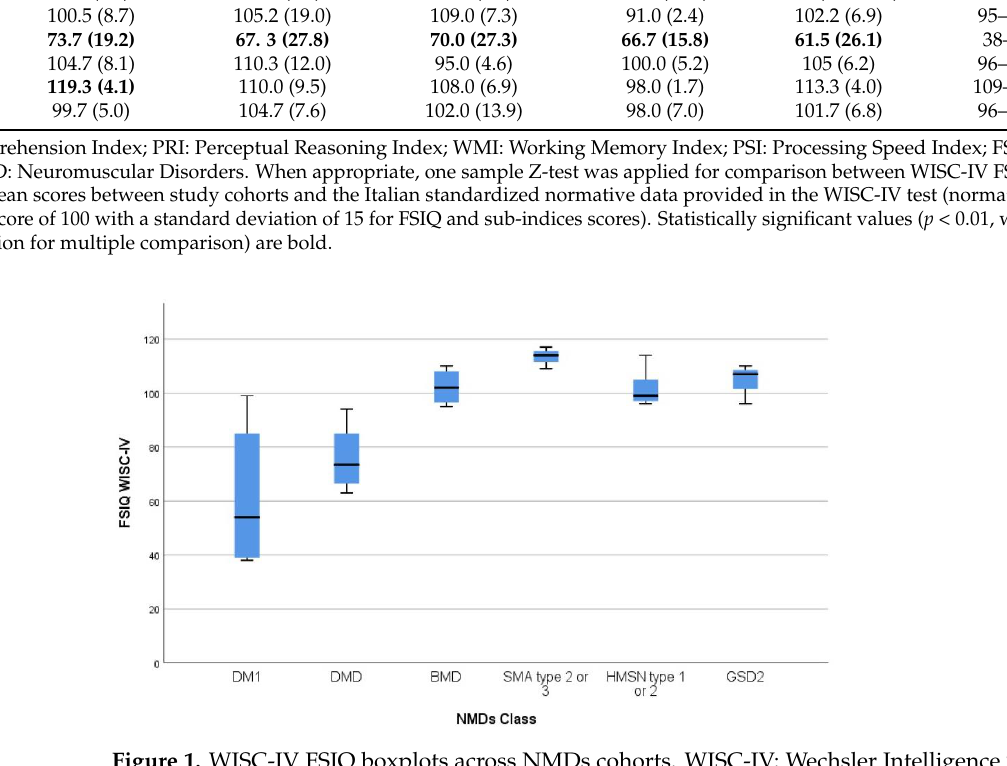
Figure 1. WISC-IV FSIQ boxplots across NMDs cohorts. WISC-IV: Wechsler Intelligence Scale for Children — Fourth Edition; FSIQ: Full Scale IQ; NMDs: Neuromuscular Disorders; DM1: myotonic muscular dystrophy type 1; DMD: Duchenne muscular dystrophy; BMD: Becker muscular dystrophy; SMA: spinal muscular atrophy, type 2 or 3; HMSN: hereditary motor sensory neuropathy, type 1 or 2; GSD2: glycogen storage disease type 2.